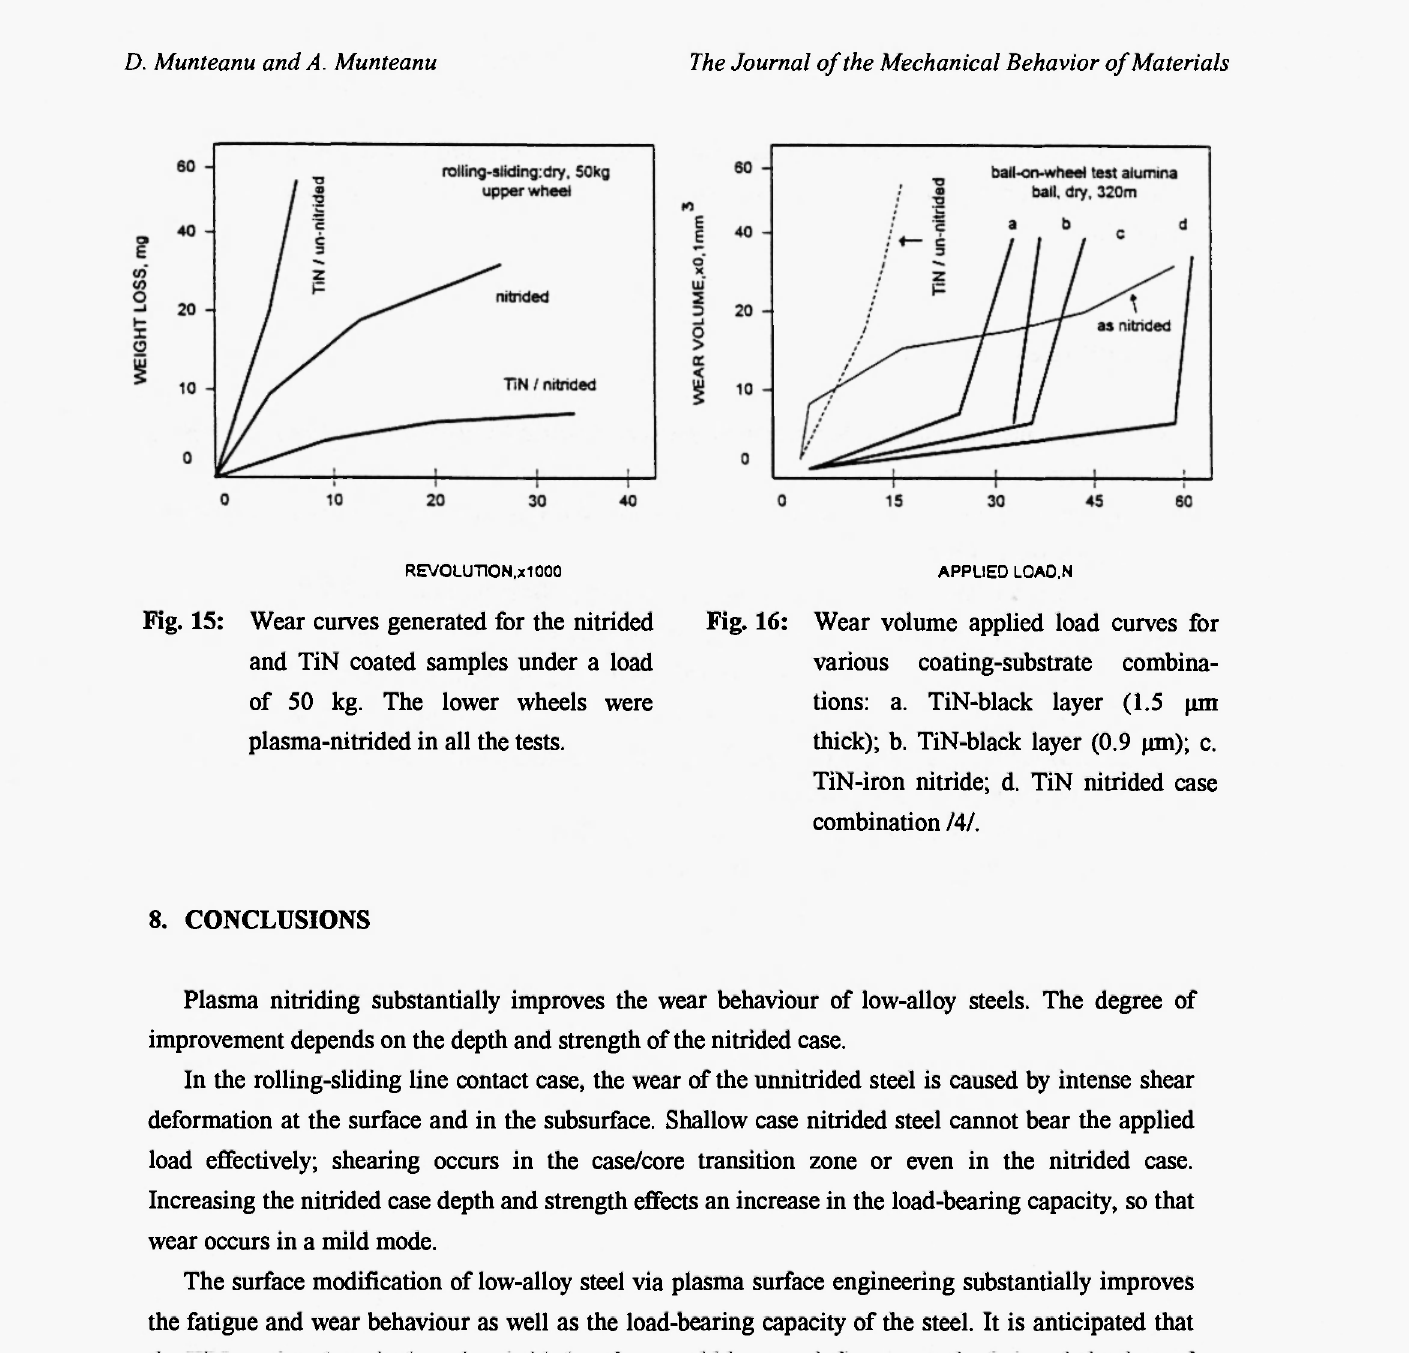
APPLIED LOAD,Ν Fig. 16: Wear volume applied load curves for various coating-substrate combina- tions: a. TiN-black layer (1.5 μιη thick); b. TiN-black layer (0.9 μηι); c. TiN-iron nitride; d. TiN nitrided case combination